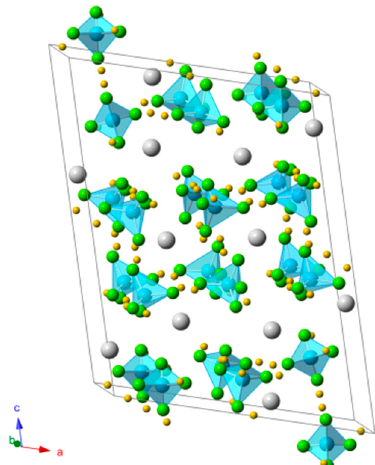
Figure 2. Packing diagram of monoclinic ( P 2 1 / c) DKDP crystal view along b axis. Grey: potassium, blue: phosphate, green: oxygen, yellow: hydrogen / deuterium.